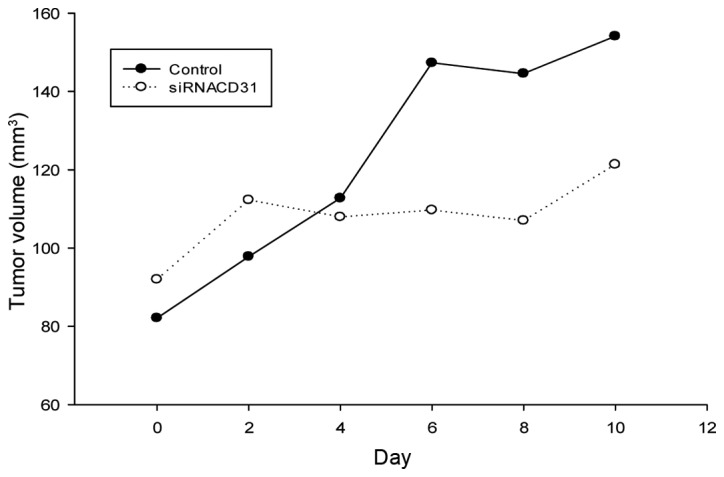
Growth of tumor xenografts of nude mice treated by the tail vein injection of siRNACD31-RNAi-mate complexes (siRNACD31 group) is slower than those treated with saline (i.e., control). The tumor xenograft volumes in the nude mice treated with siRNACD31-RNAi-mate complexes were smaller than those in the control nude mice from day 4, and the deviation of tumor volumes (DV) increased, continuing to day 10. siRNA, small interfering RNA; CD31, cluster of differentiation 31; RNAi, RNA interference.